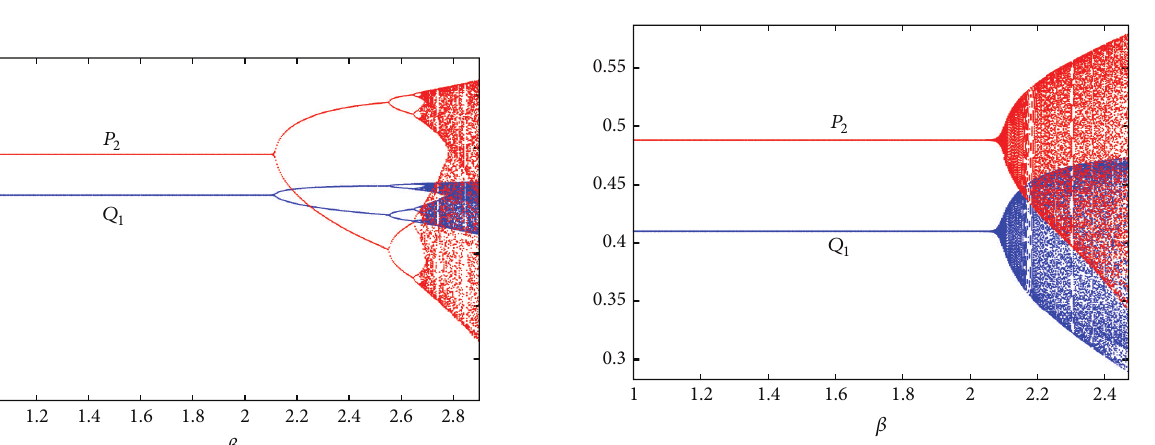
Figure 2: The parameter basin plots of system (10) for 𝑘 = 0.3 .